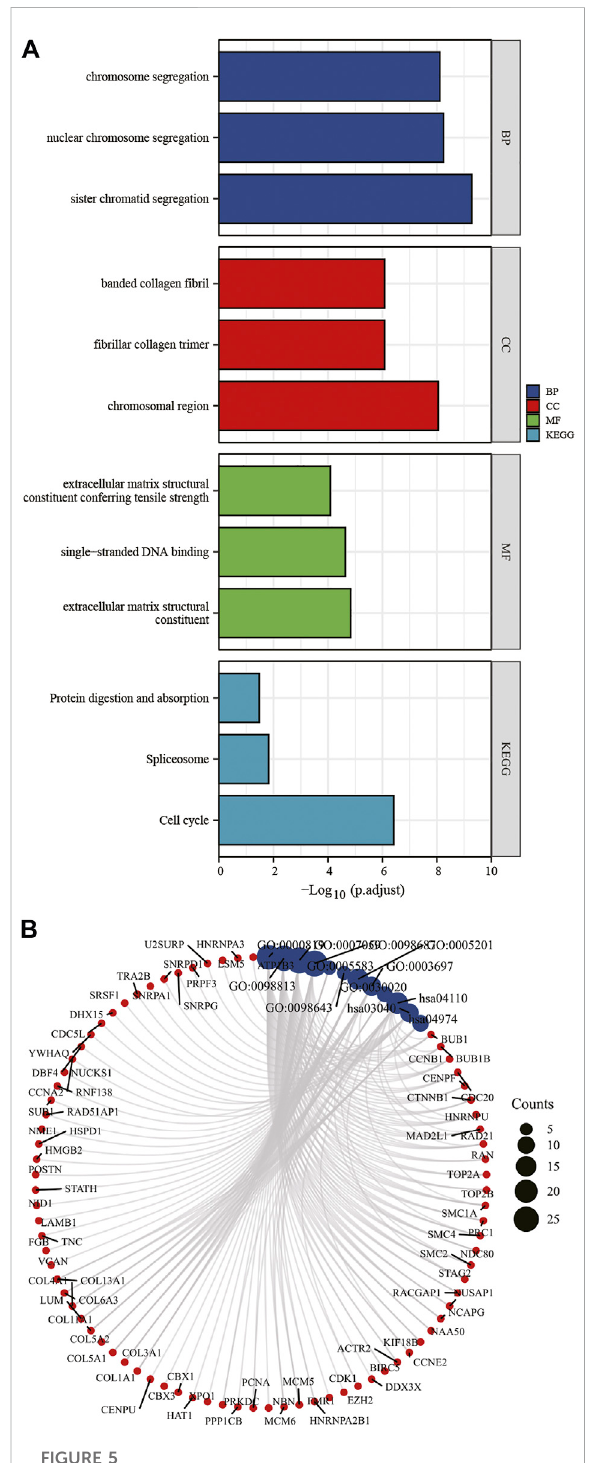
FIGURE 5 KEGG and GO enrichment analysis of DEGs (A,B) . DEGs, differentially expressed genes; GO, Gene Ontology; BP, biological process; CC, cellular component; MF, molecular function. KEGG, Kyoto Encyclopedia of Genes and